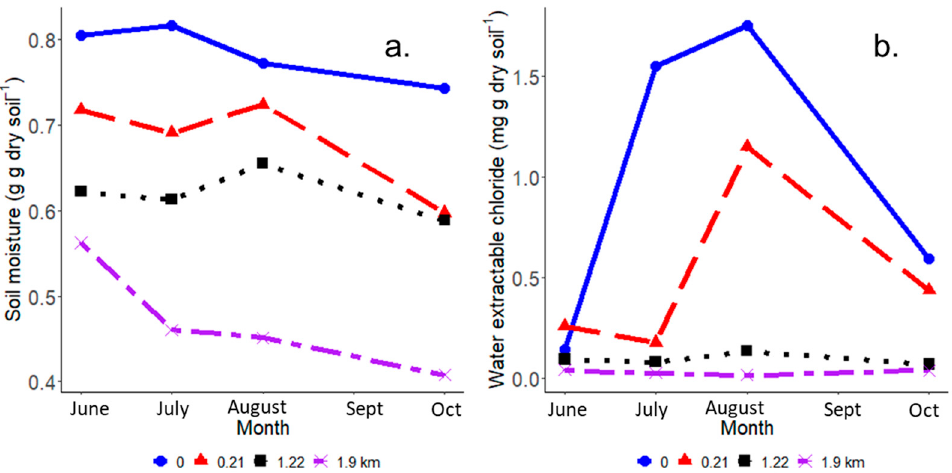
Figure 3. ( a ) Gravimetric soil moisture (g water g dry soil − 1 ) and ( b ) Water extractable Cl − (mg Cl − g dry soil − 1 ) with distance from the most downstream site (km) per month (June-October).